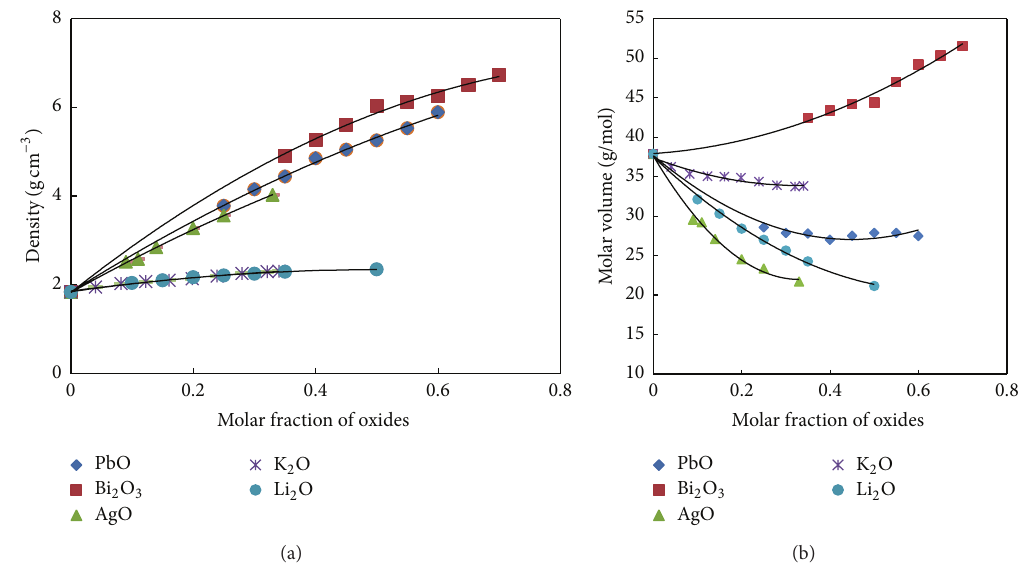
Figure 1: (a) Density ( 𝜌 ) and (b) molar volume ( 𝑉 𝑚 ) of binary borate glasses as a function of modifier oxide concentrations of Pb and Bi oxides with those of Ag, K, and Li [22, 23].